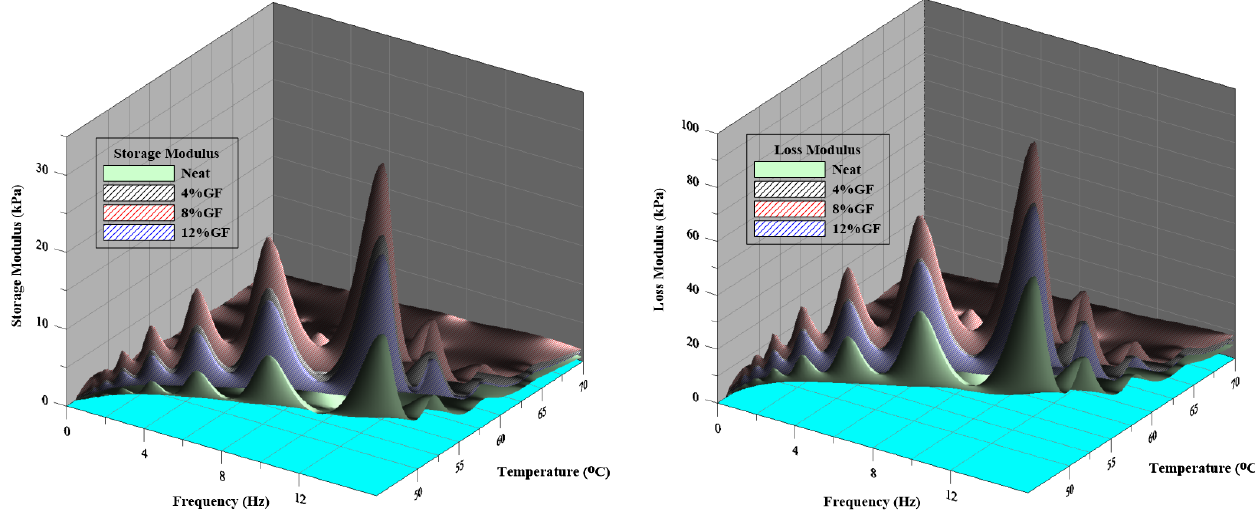
Figure 5. Temperatures and frequencies effects on the G (cid:48) and G (cid:48)(cid:48) of GF.